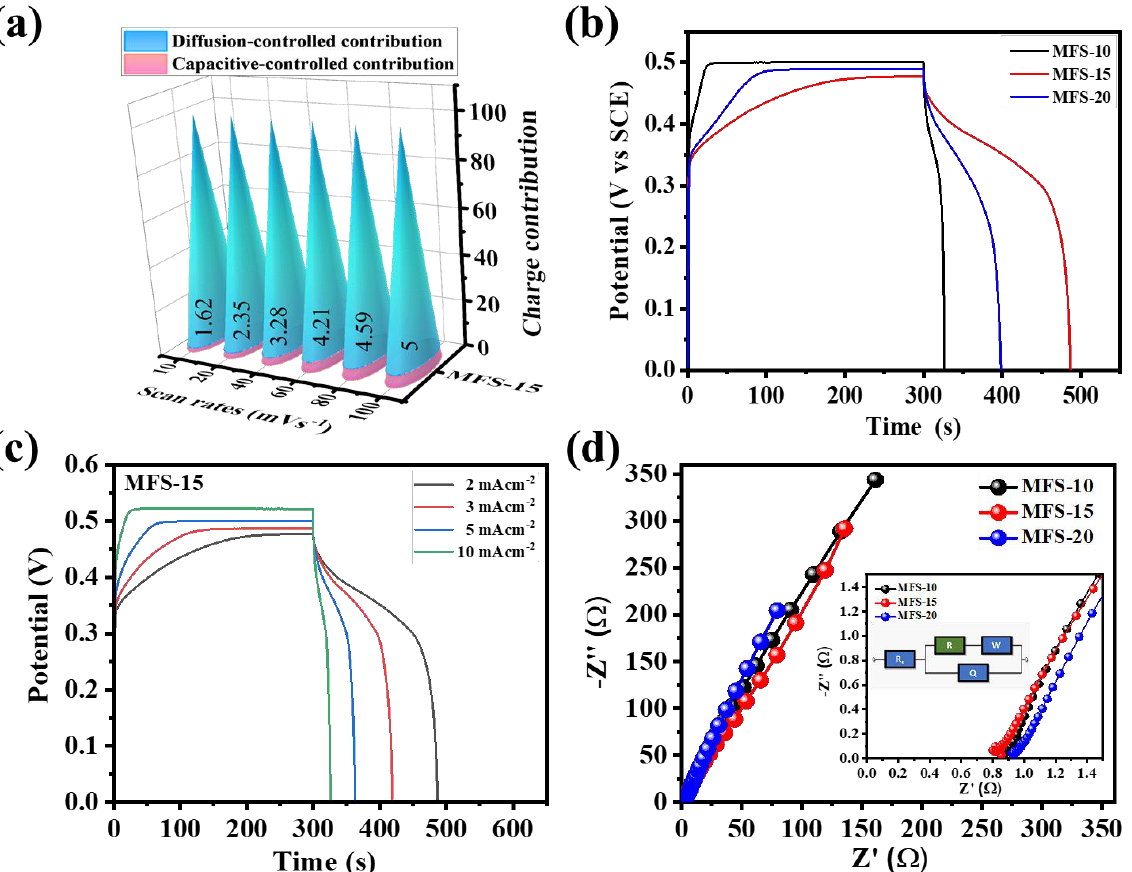
Figure 5. ( a ) Capacitive and diffusive -controlled contribution at different scan rates (10 – 100 mV s − 1 ) for MFS-15 electrode, ( b ) galvanostatic charge – discharge (GCD) of MFS electrodes measured at 2 mA cm − 2 current density, ( c ) GCD of MFS-15 electrode measured at different current densities (2 – 10 mA cm − 2 ), and ( d ) electrochemical impedance spectroscopy of MFS-electrode measured at 10 mV potential within a 10 5 to 0.1 Hz frequency range.